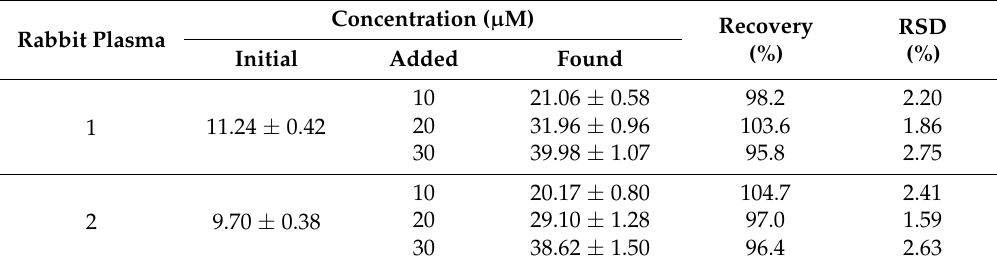
Table 3. Metronidazole determination in rabbit plasma ( n = 6).